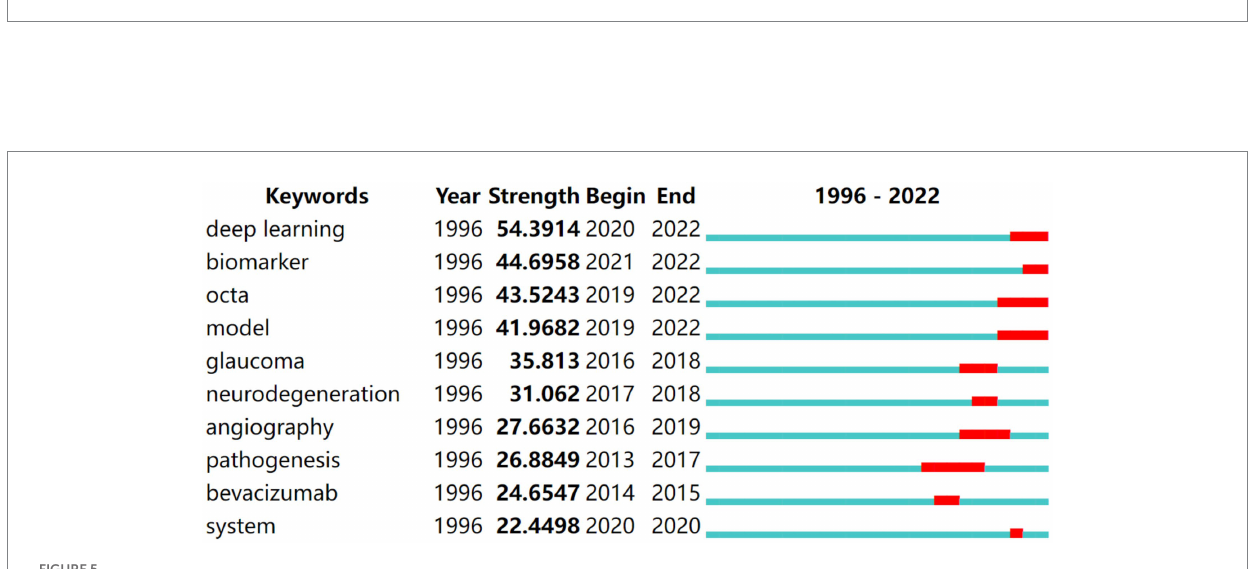
FIGURE 5 Top 10 keywords with the strongest citation bursts in DR research. The blue lines represent the base timeline, while the red segments represent the duration of the keyword burst, and the two endpoints correspond to the beginning and end times of the